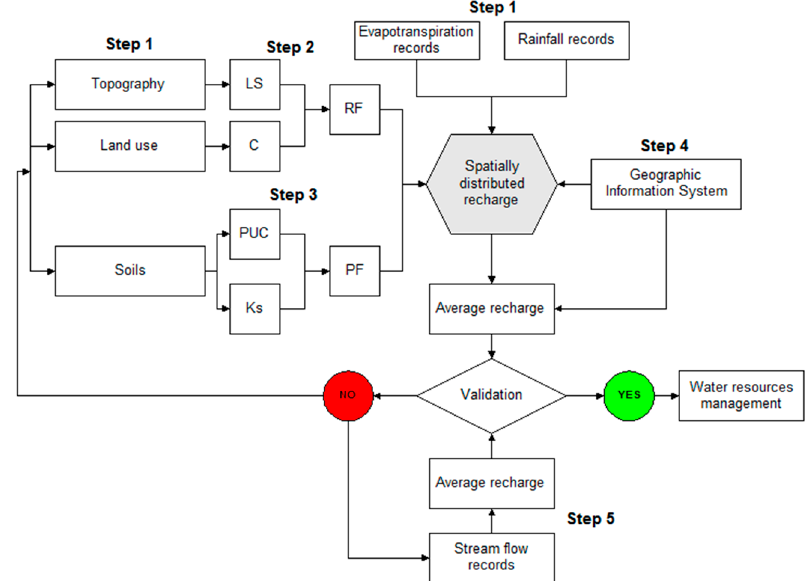
Figure 6. Flowchart for the groundwater recharge potential calculation and model validation. Adapted from Costa et al. (2019) [10]. Abbreviations: LS—slope length and steepness factor [57]; C—runoff coefficient (Table 7); RF—runoff factor (Equation (1)); PUC—Conservative Use Potential [43]; Ks—soils’ hydraulic conductivity (Table 8); PF—water percolation factor (Equation (2)).